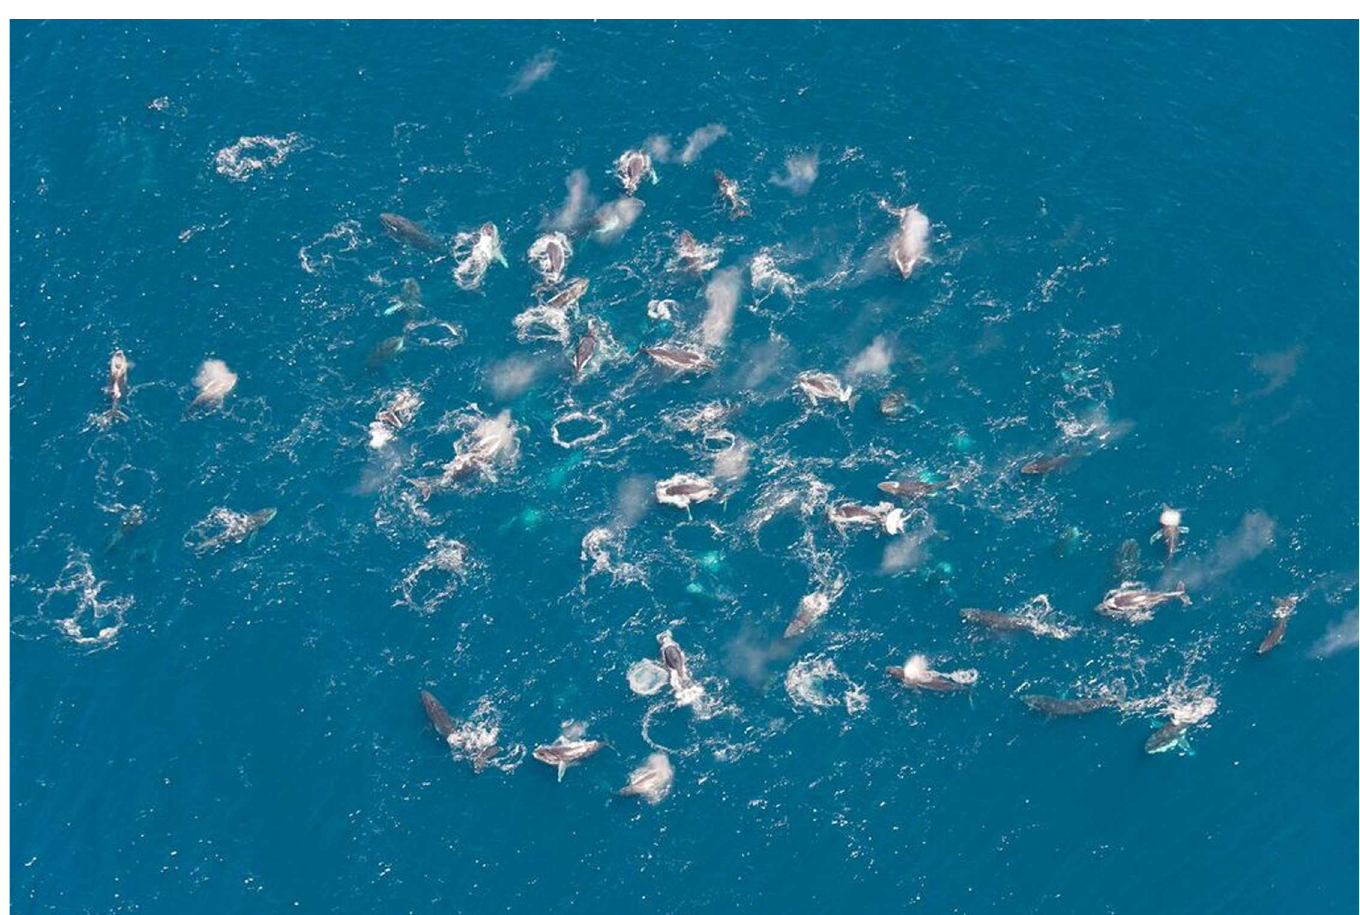
Fig 2. Aerial incidental observation (Observation 7, Table 2) of a “super-group” encountered some 5 km west of Crayfish Factory on the west coast of the Cape Peninsula, South Africa. Image courtesy of Jean